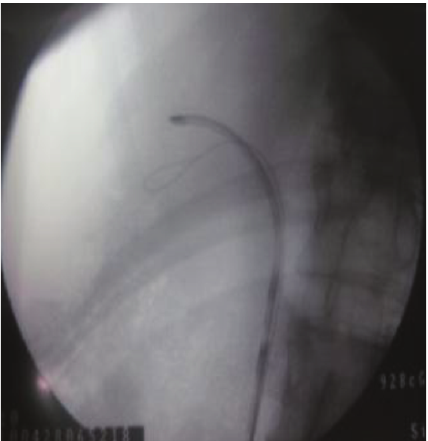
Figure 3: Ureteroscope in the upper tract.